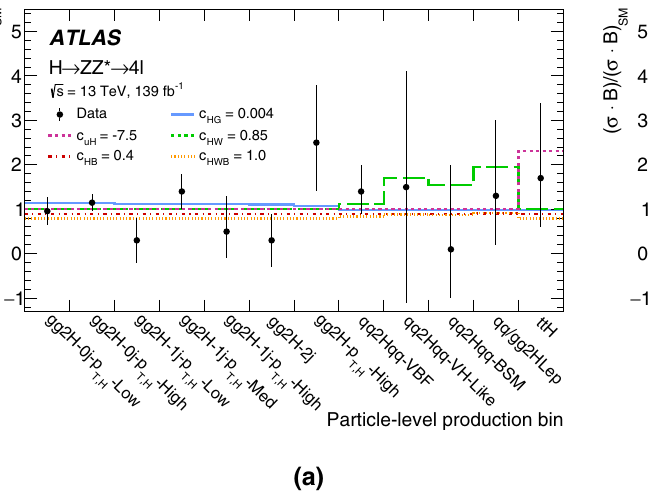
Fig. 15 The expected signal yield ratio for chosen ( a ) CP-even and ( b ) CP-odd EFT parameter values together with the corresponding cross- section measurement in each production bin of Reduced Stage 1.1. The